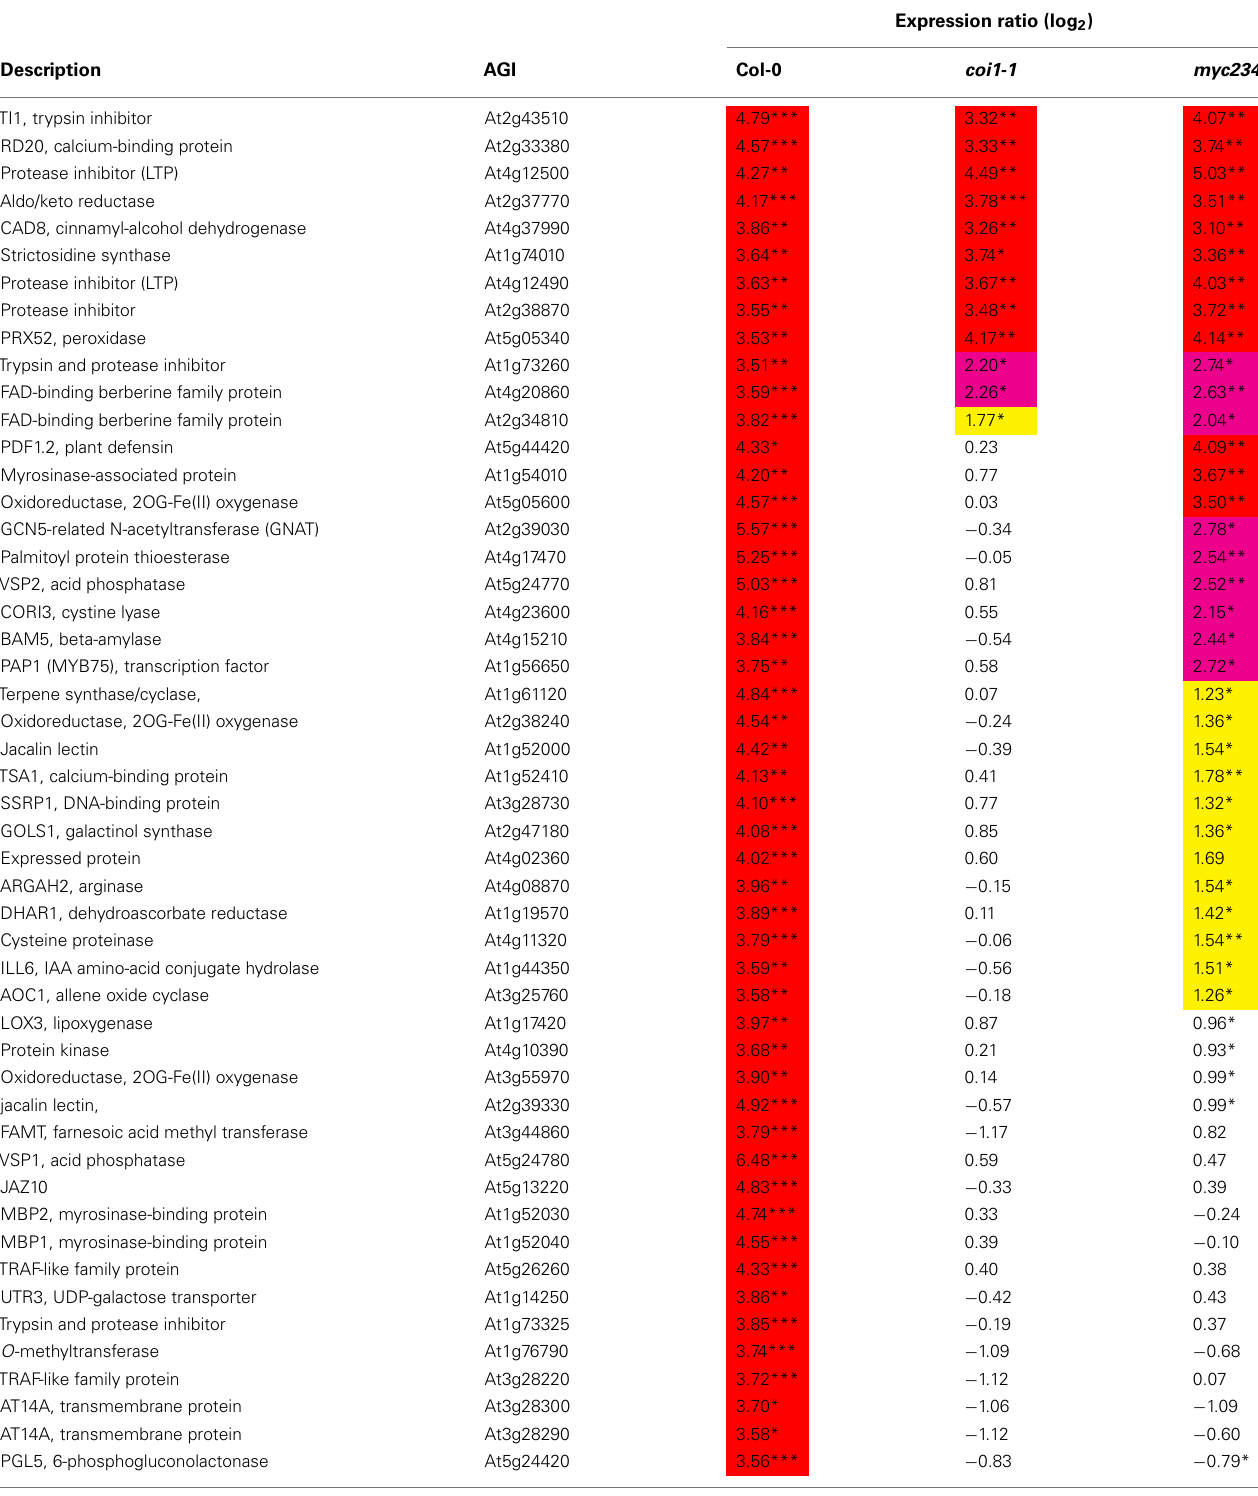
Table 2 | List of insect-induced